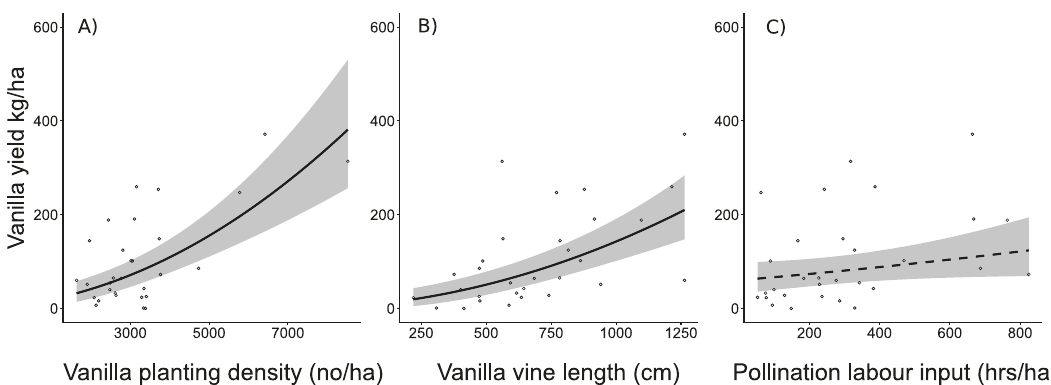
Fig. 3 Management and environmental variables in fl uencing vanilla yield in 30 vanilla agroforests in north-eastern Madagascar based on a linear mixed-effect model with yield sqrt-transformed. Dots are raw data and solid and dashed lines indicate statistically signi fi cant ( p < 0.050) and marginally signi fi cant effects (0.050 < p < 0.100), respectively. Trend lines show average values of the backtransformed model predictions of the fi nal model after using likelihood ratio tests using maximum-likelihood estimation, shaded areas indicate 95% con fi dence intervals. The full model included: vanilla planting density, pollination labour input, vanilla vine length, vanilla plant age, soil characteristics, canopy closure, slope, landscape forest cover, understory vegetation cover, and elevation. The fi nal model included: vanilla planting density, pollination labour input, vanilla vine length. Statistical test results in Supplementary Tables 6 and